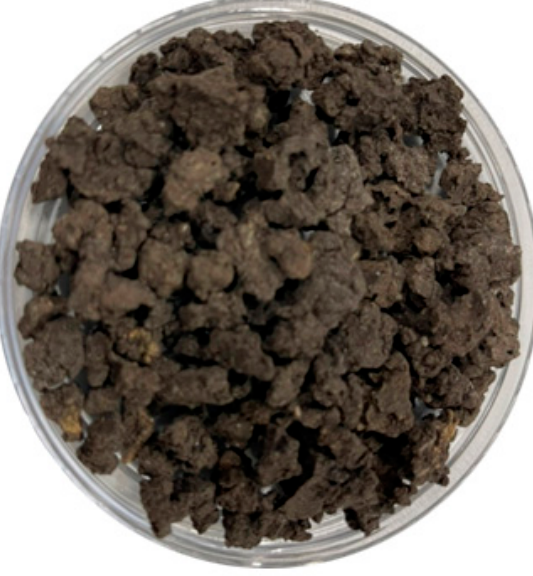
Figure 1. A photograph of palm oil sewage sludge bio-char.